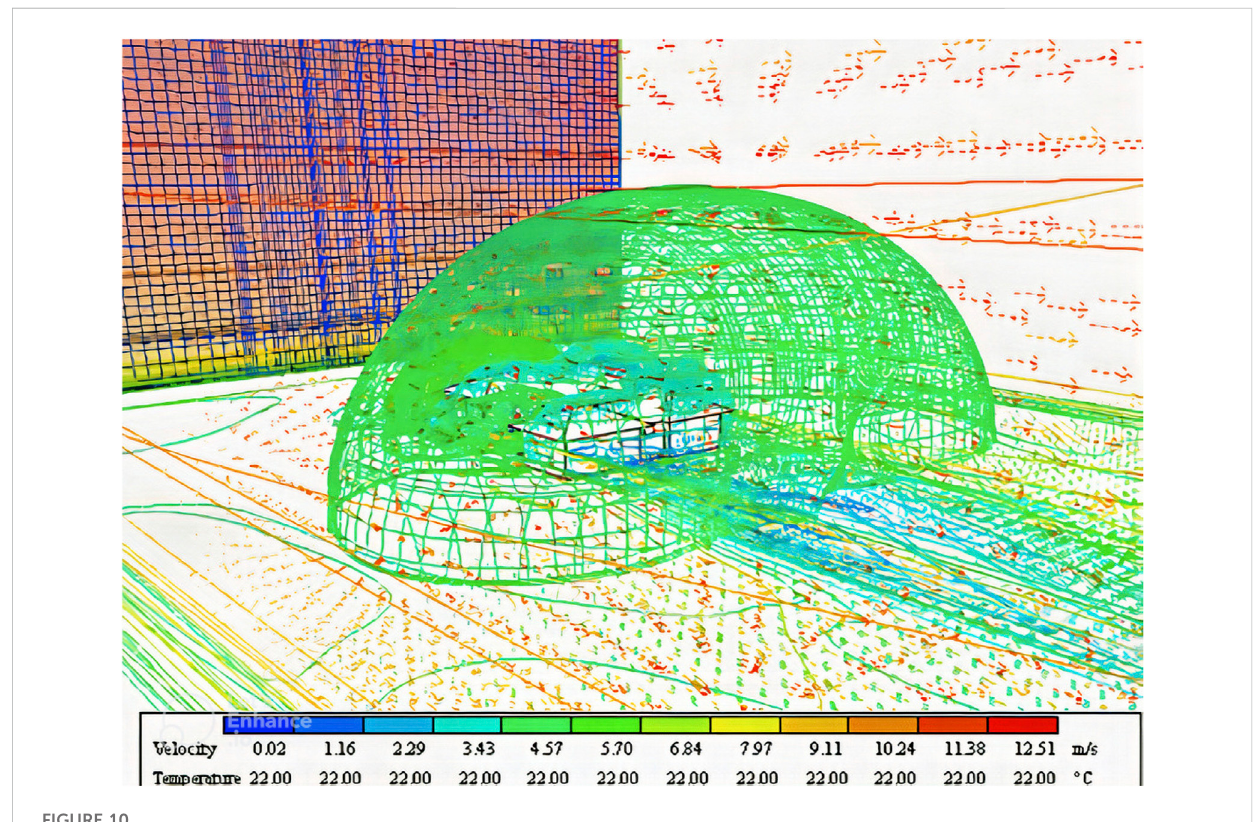
FIGURE 10 Worst-case situation — scattering with canceling effect wind streams.